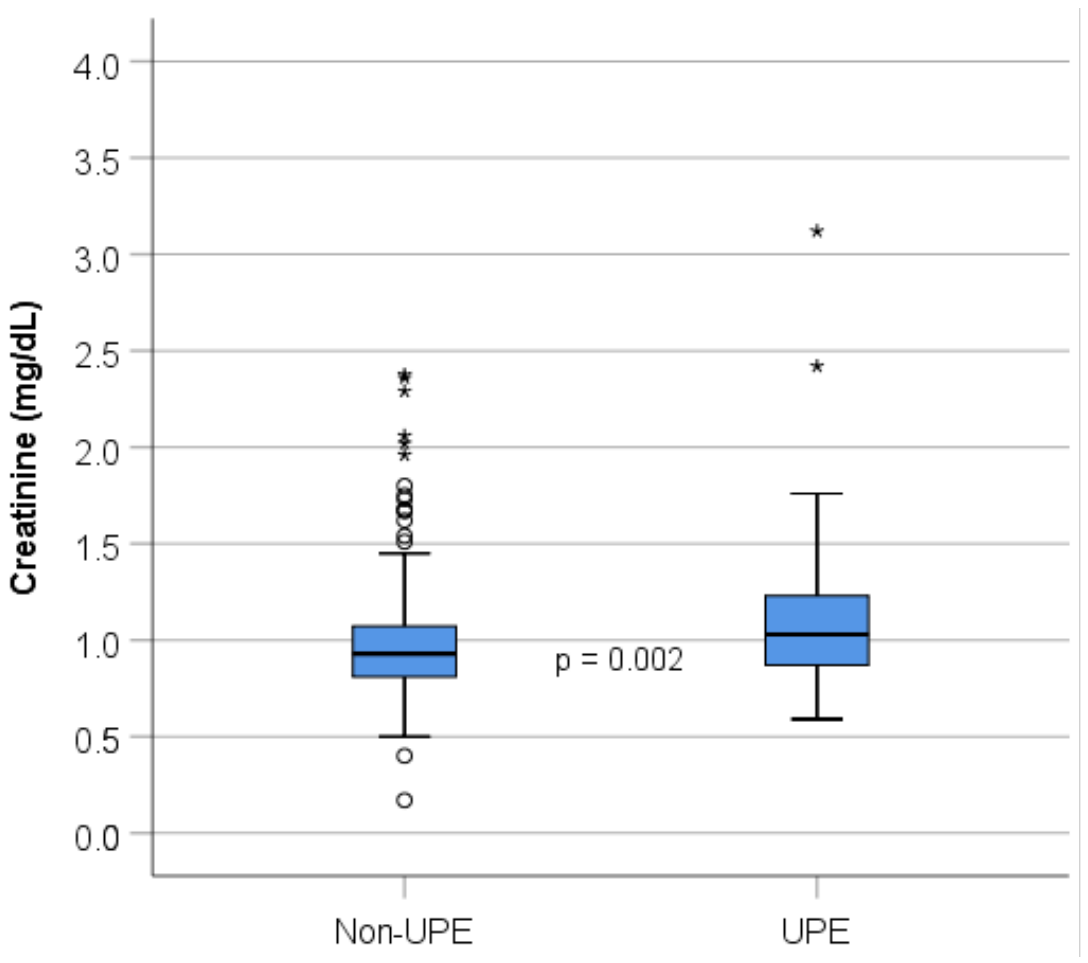
Figure 3. Creatinine levels in the non-UPE and the UPE groups. UPE, unilateral-pulmonary-edema; one outlier (non-UPE, 7.6 mg/dL) was excluded for the graphical representation. ◦ outlier; * extreme outlier.